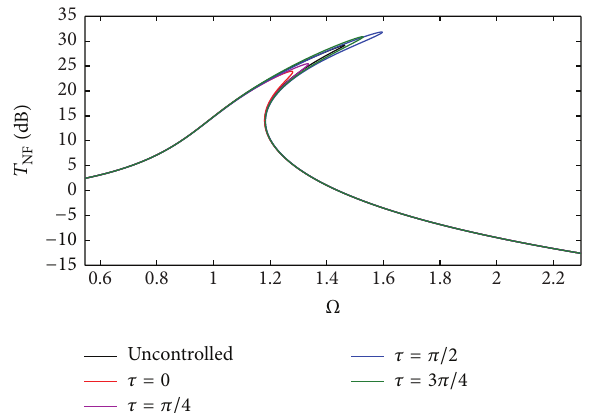
Figure 17: Force transmissibility of the controlled system with different time delay 𝜏 ( 𝜁 1 = 0.025 , 𝜁 3 = 0.025 , 𝑓 1 = 0.05 , 𝑘 = 1 , ̂𝜆 = 0.4 and